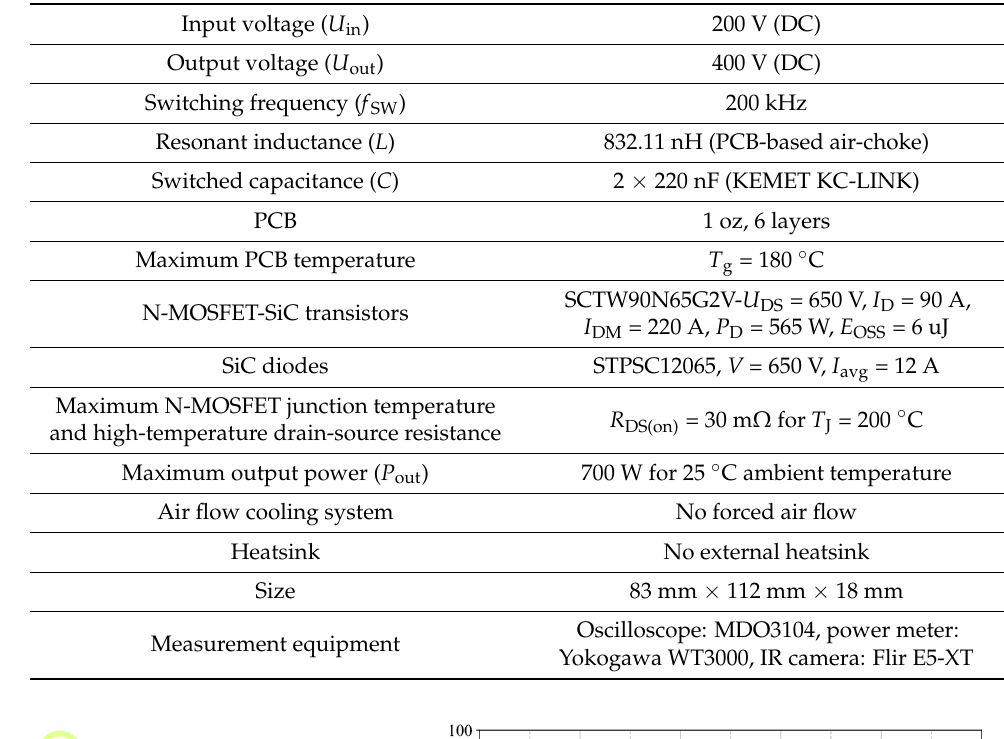
Table 2. Parameters of the experimental setup and its implementation.